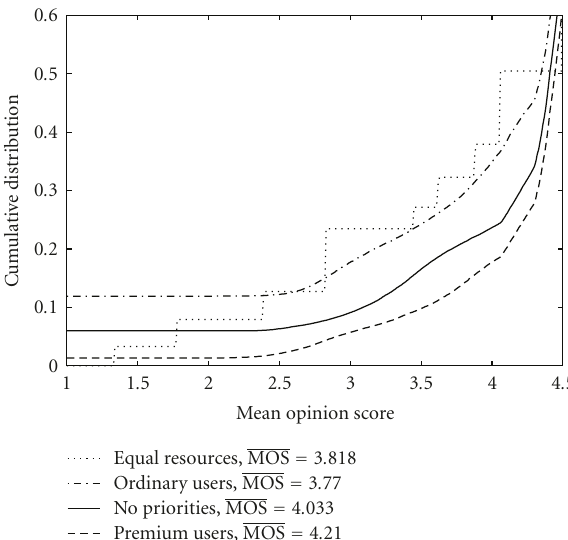
Figure 10: CDF of the perceived quality for di ff erent minimum MOS constraints MOS stop . For comparison the “increase sum MOS” variant is also included.